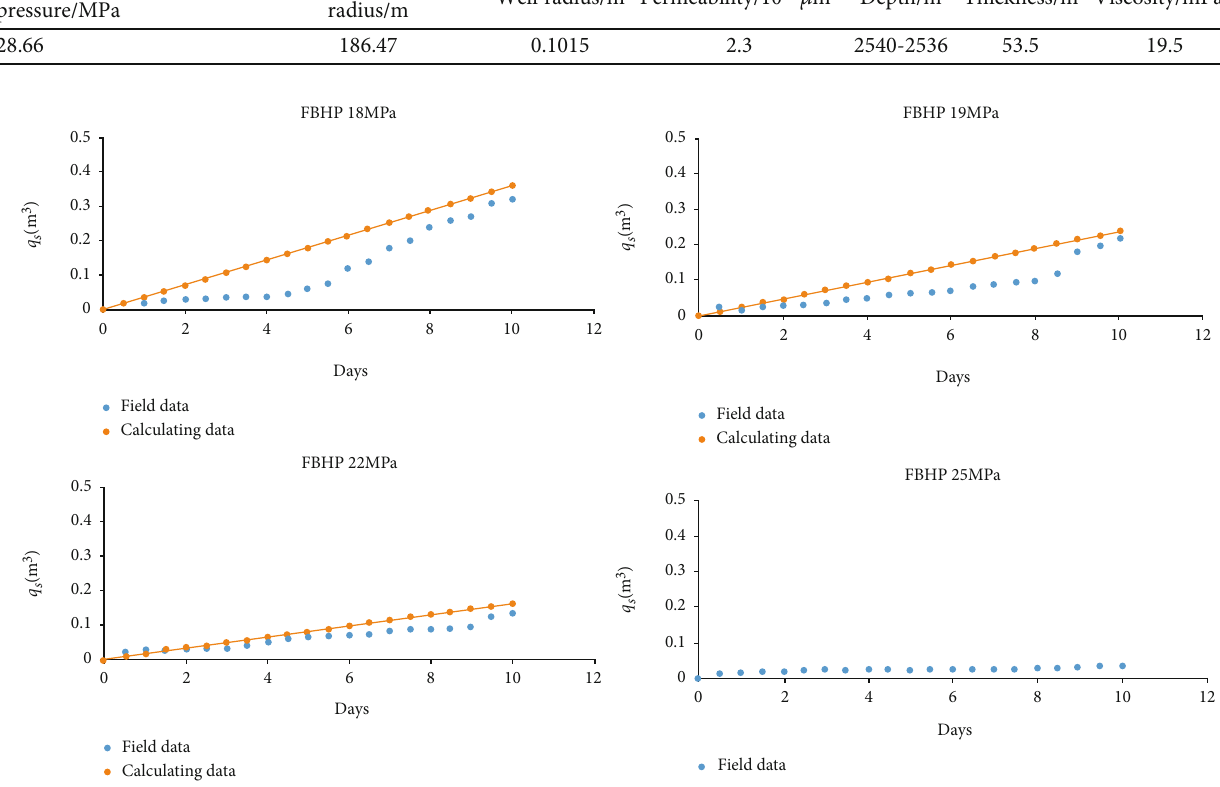
Figure 4: Relationship between fl owing bottom-hole pressure and sand production